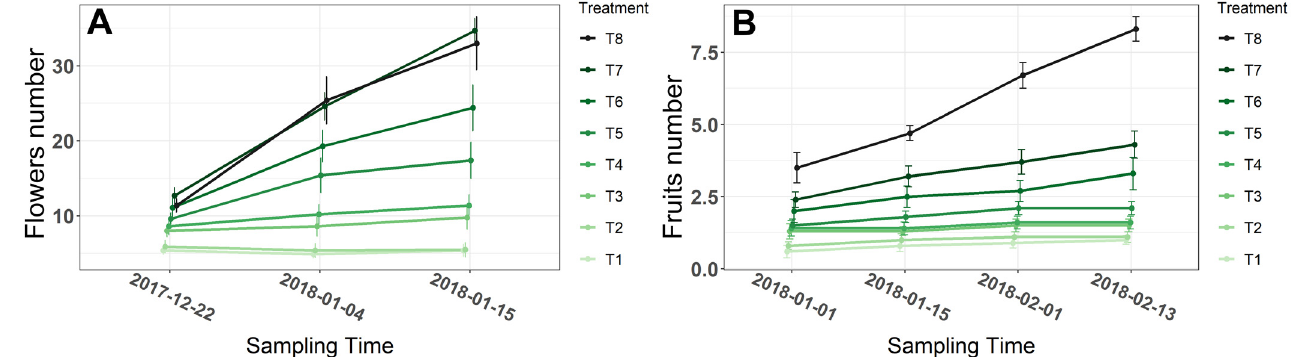
Figure 4. Line graphs including mean values of flower ( A ) and fruit ( B ) production for eight treatments representing increasing UWP supplement rates (T1 = 0.3%; T2 = 0.5%; T3 = 0.8%; T4 = 1%; T5 = 2%; T6 = 3%; T7 = 5%), and Hoagland’s solution (T8). x -axis represents sampling events in weeks after planting. Error bars denote standard errors.